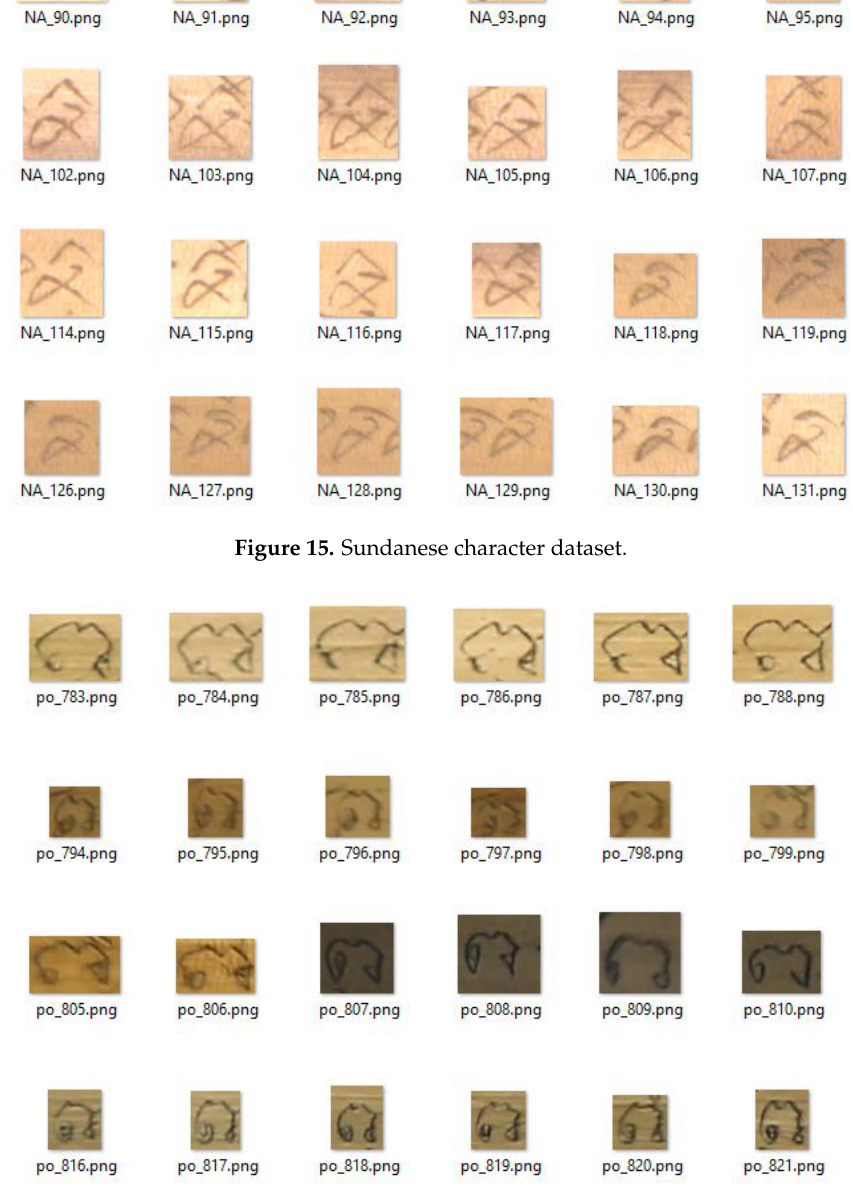
Figure 16. Khmer character dataset.